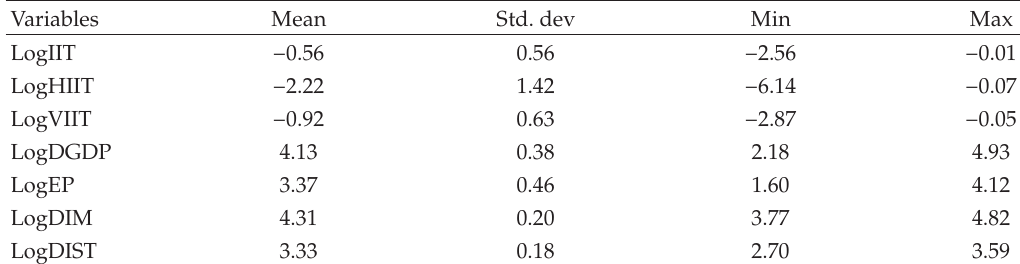
Table 1: Summary statistics.